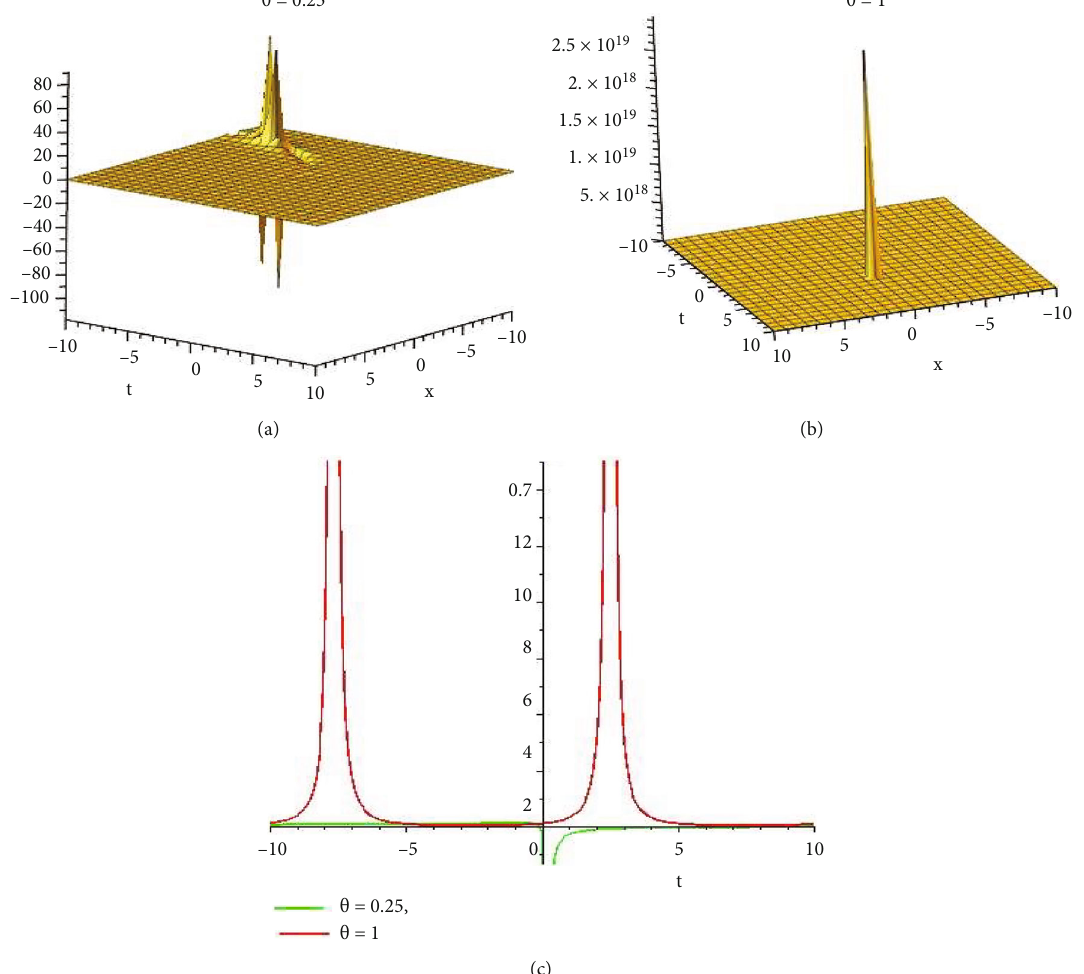
, y , t Þ . (a, b) 3D plot and (c) 2D combined plot for x = 1 10,11 ð x